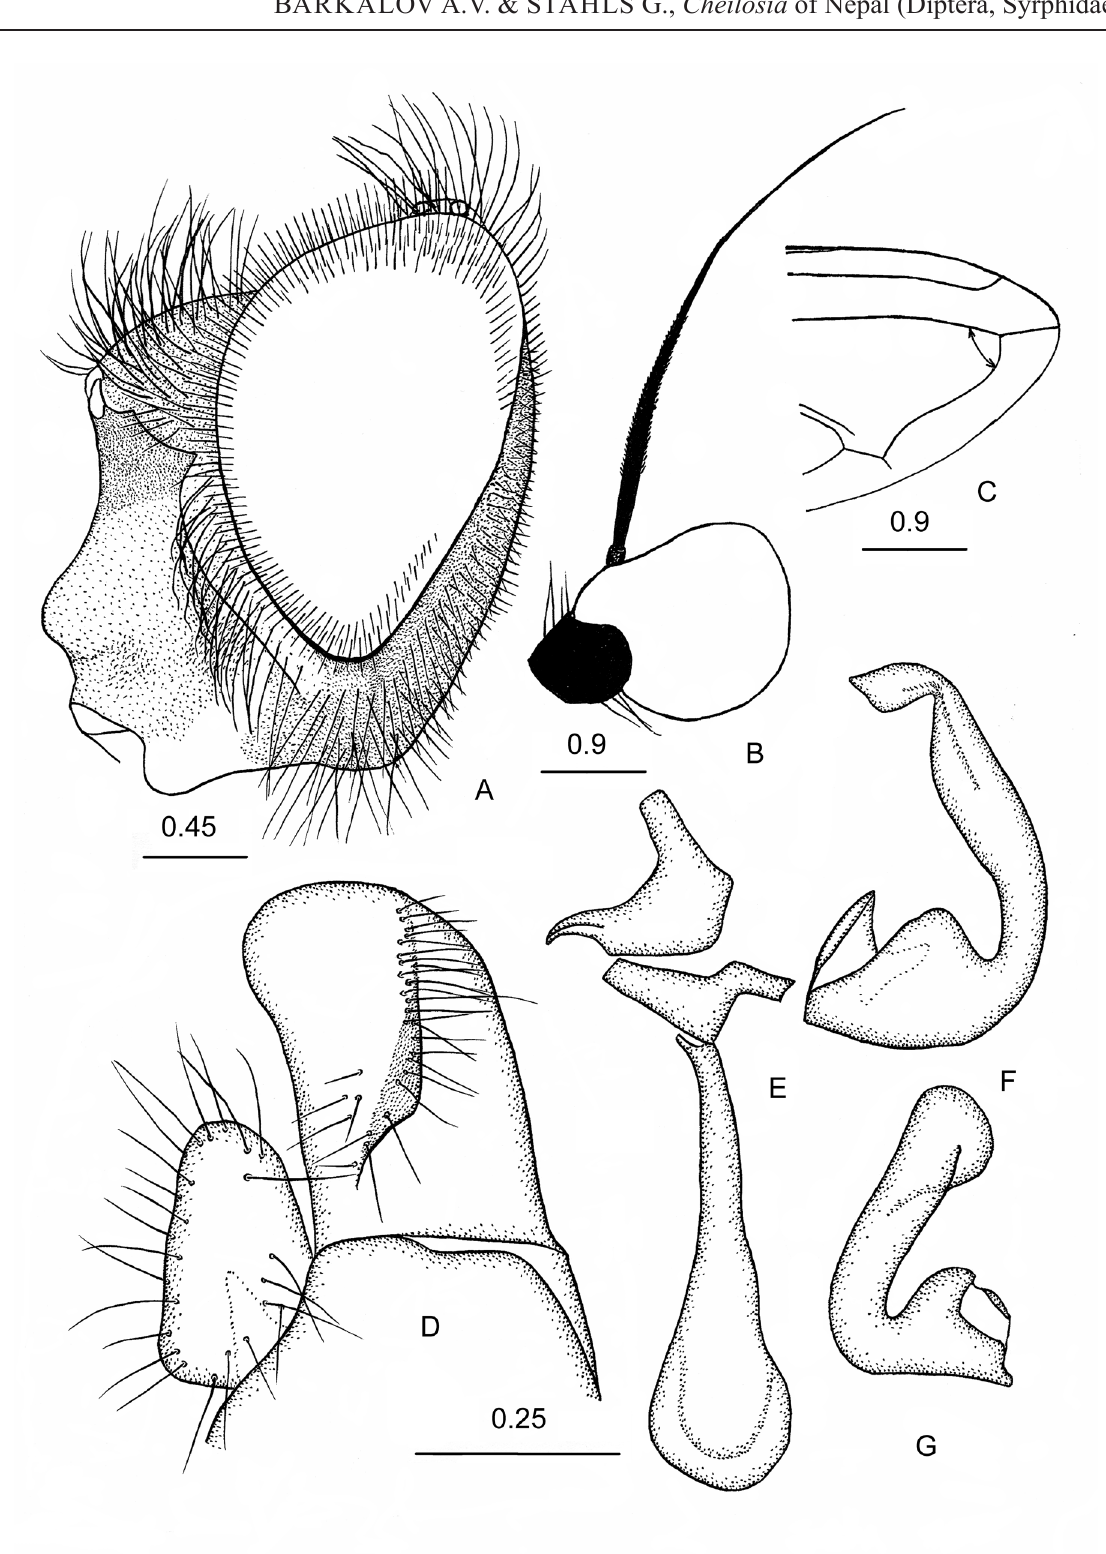
Fig. 50. Cheilosia ( Montanocheila ) picta sp. nov., holotype, ♂ (CNC). A . Head, lateral view. B . Antenna, lateral view of pedicel and basoflagellomere. C . Tip of wing. D . Surstylus and gonocercus, lateral view. E . Aedeagus and aedeagal apodeme, lateral view. F–G . Superior lobe of hypandrium, lateral view. Scale bars indicated in